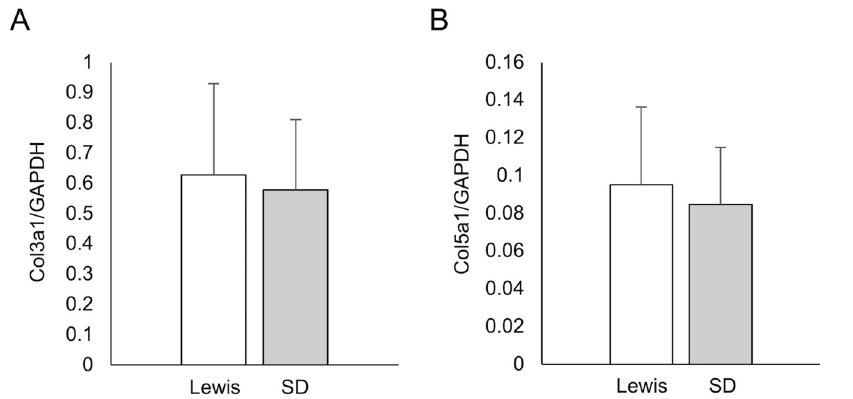
Fig 4. Real-time PCR analyses of the Col3a1 and Col5a1 mRNA expression in the pancreatic tissues of each rat strain. (A) Col3a1/GAPDH ratio. (B) Col5a1/GAPDH ratio. In all analyses, GAPDH was used as a housekeeping gene.